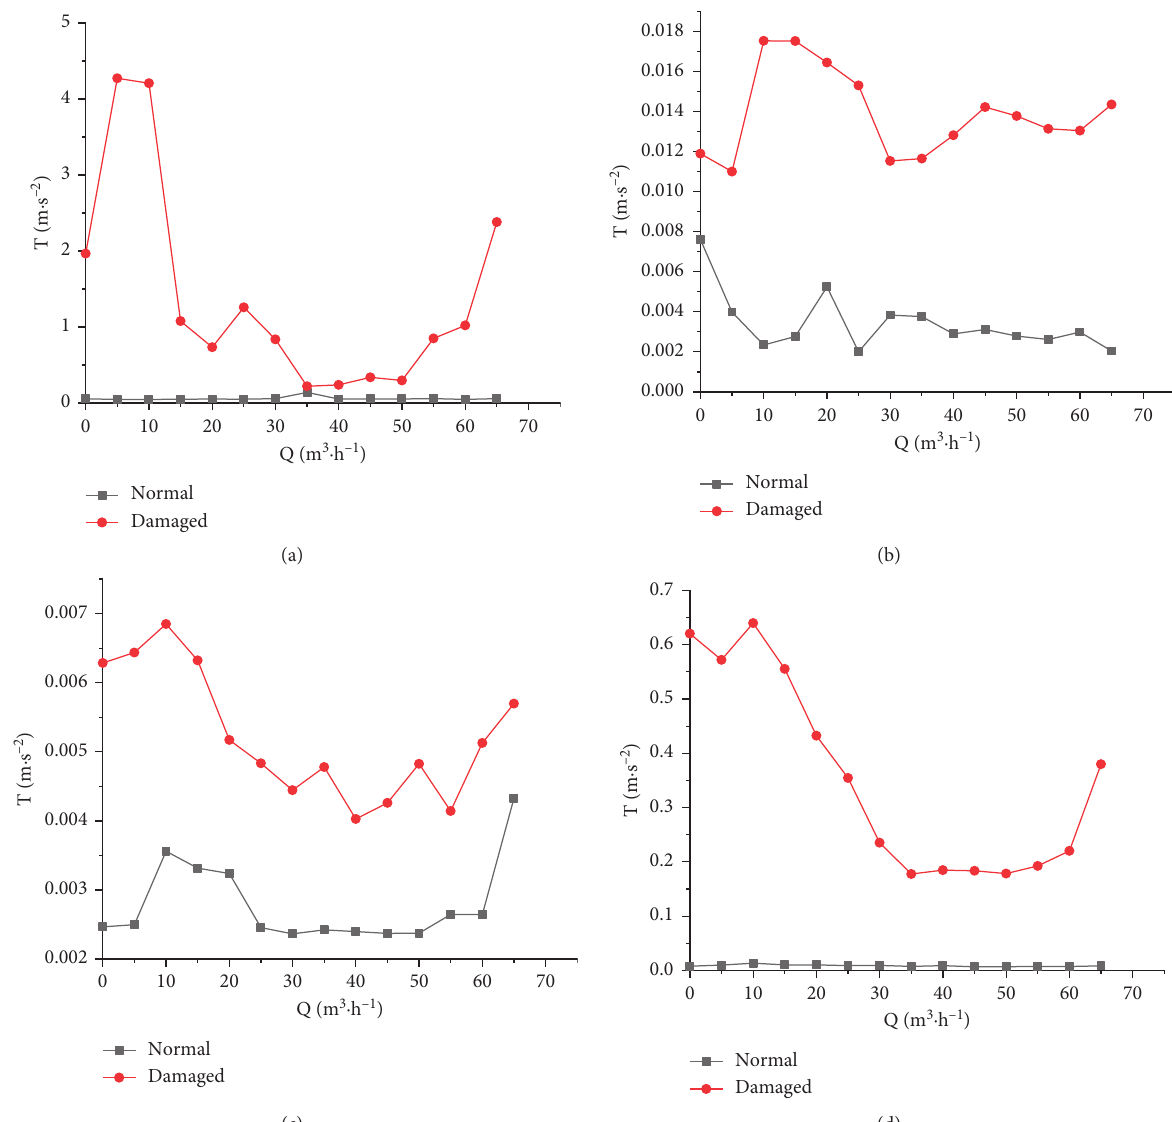
Figure 4: The vibration intensity varies with the flow curve. (a) Base RMS of vibration signal. (b) Radial direction RMS of vibration signal. (c) Axial direction RMS of vibration signal. (d) Vertical direction RMS of vibration